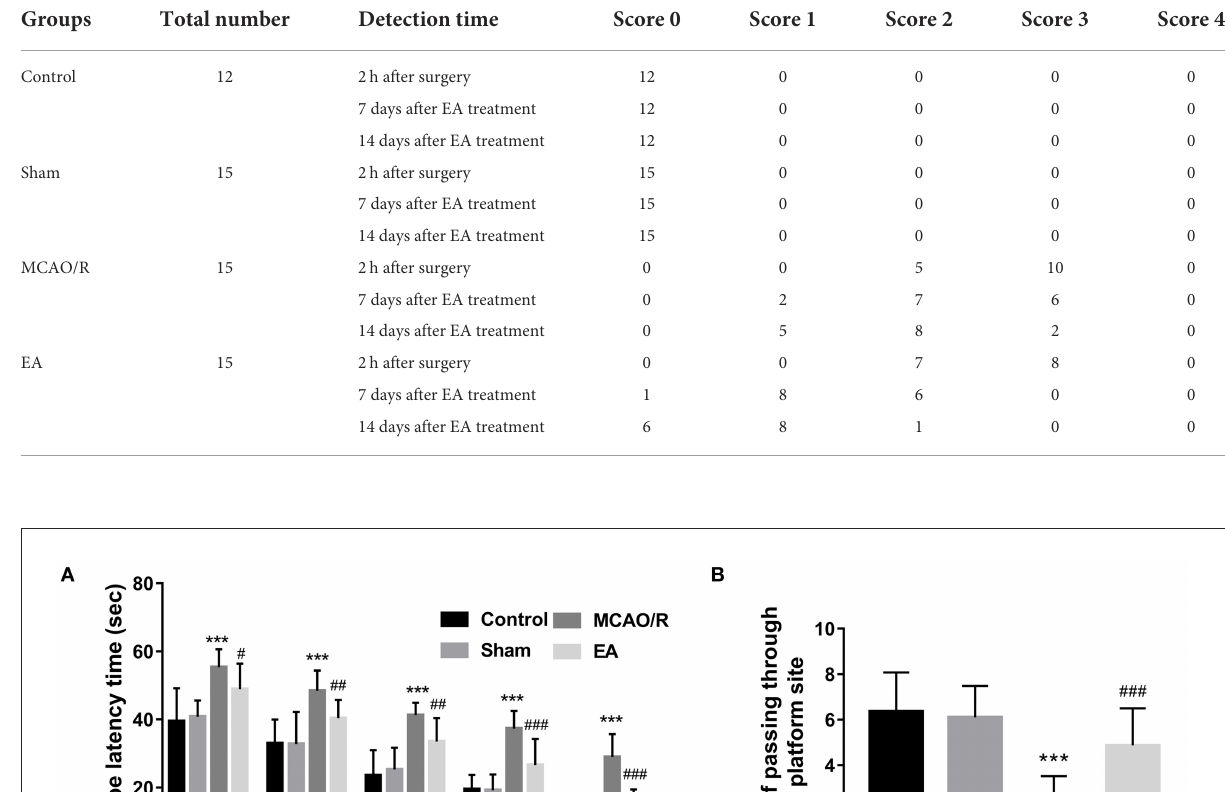
and semaphorin 4D (Sema4d)] (Figure 6B). Given the vital roles